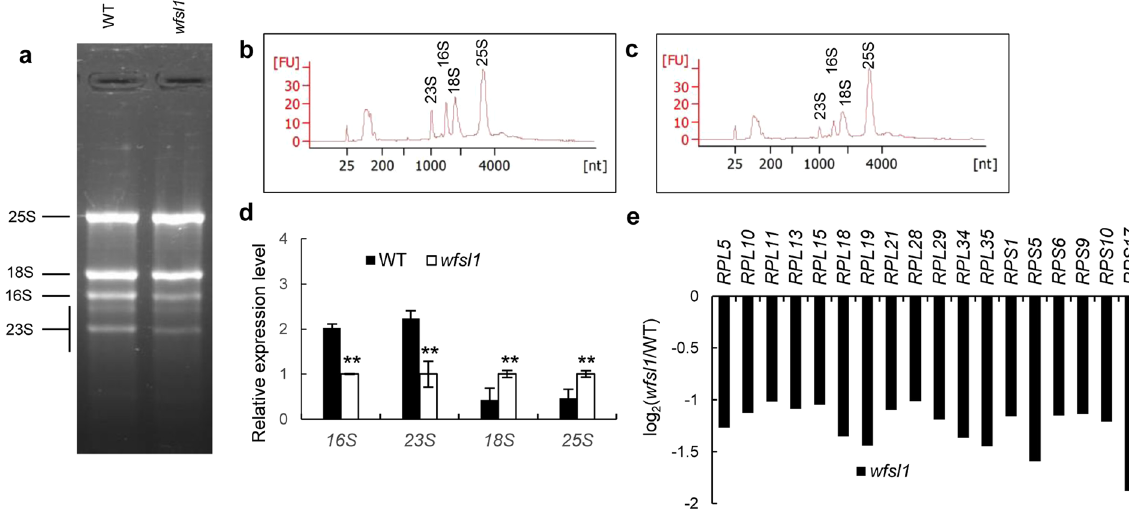
Figure 8. Analysis of rRNA and chloroplast ribosomal gene expression in wild type and wfsl1 . ( a ) Total RNA from wild type and wfsl 1 at tillering stage. ( b , c ) rRNA analysis from wild type and wfsl1 using Agilent 2100, respectively. ( d ) qRT-PCR analysis of the expression level of 16 S, 23 S, 18 S and 25 S in wild type and wfsl1 plants. ( e ) RNA-seq analysis of chloroplast ribosomal genes. RNA was isolated from wild type and wfsl1 at tillering stage. Error bars represent the SD from three independent experiments (Student’s t -test, * P < 0.05; ** P <